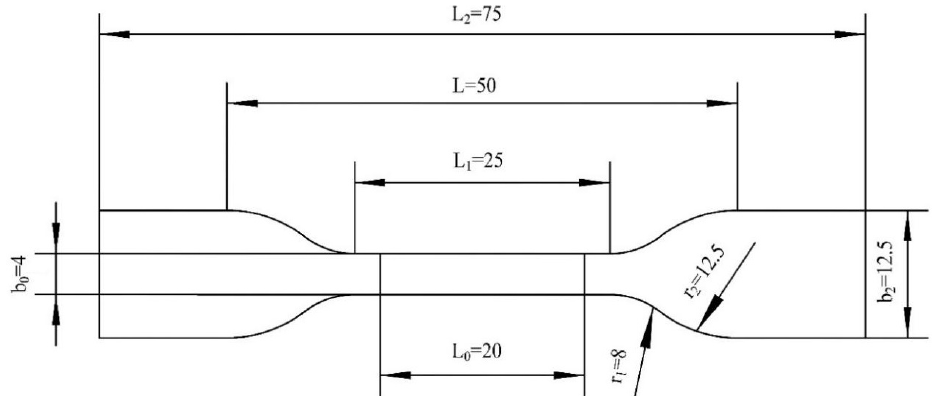
Figure 9. Schematic diagram of 5A standard sample.